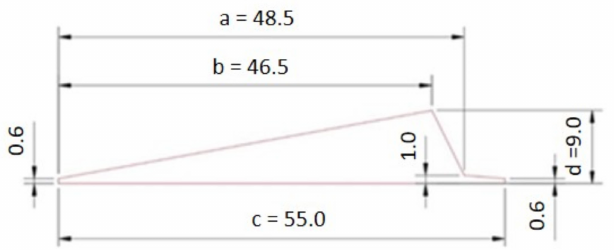
Figure 12. The resulting shape and dimensions of the apex after